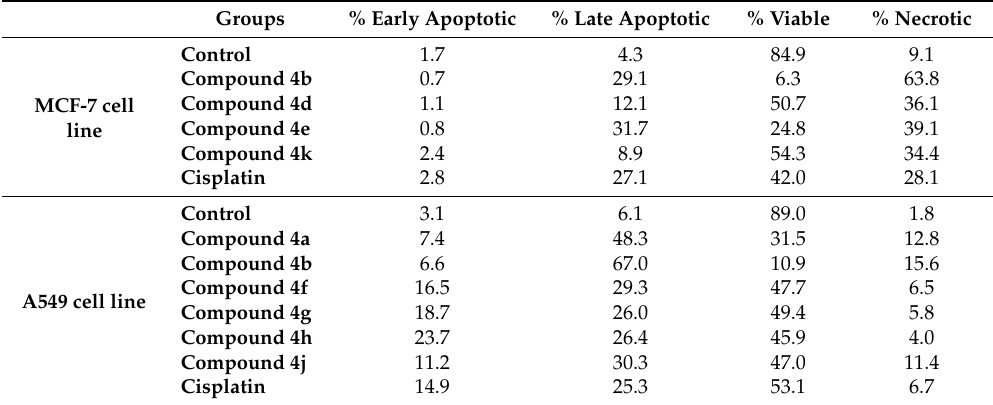
Figure 4. DNA synthesis inhibitory activity of compounds 4a , 4b , 4f , 4g , 4h , 4j and cisplatin on A549 cells. Mean percent absorbance of untreated control cells were assumed 0%. In addition, two different concentrations (1: IC 50 /2; 2: IC 50 µM) of test compounds and cisplatin were given. Data points represent means for three independent wells ± SD. p < 0.05. Table 3. Percents of typical quadrant analysis of Annexin V FITC/Propidium Iodide flow cytometry of MCF-7 and A549 cells treated with compounds and Cisplatin.